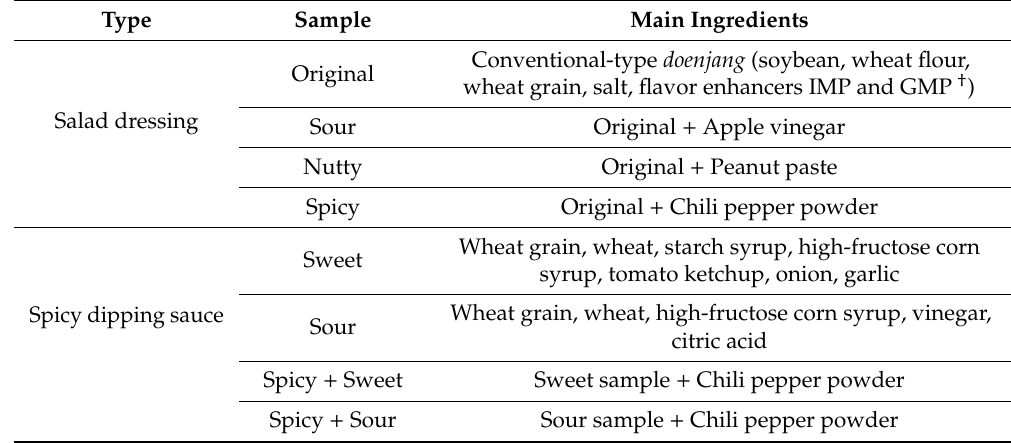
Table 2. Products’ ingredient